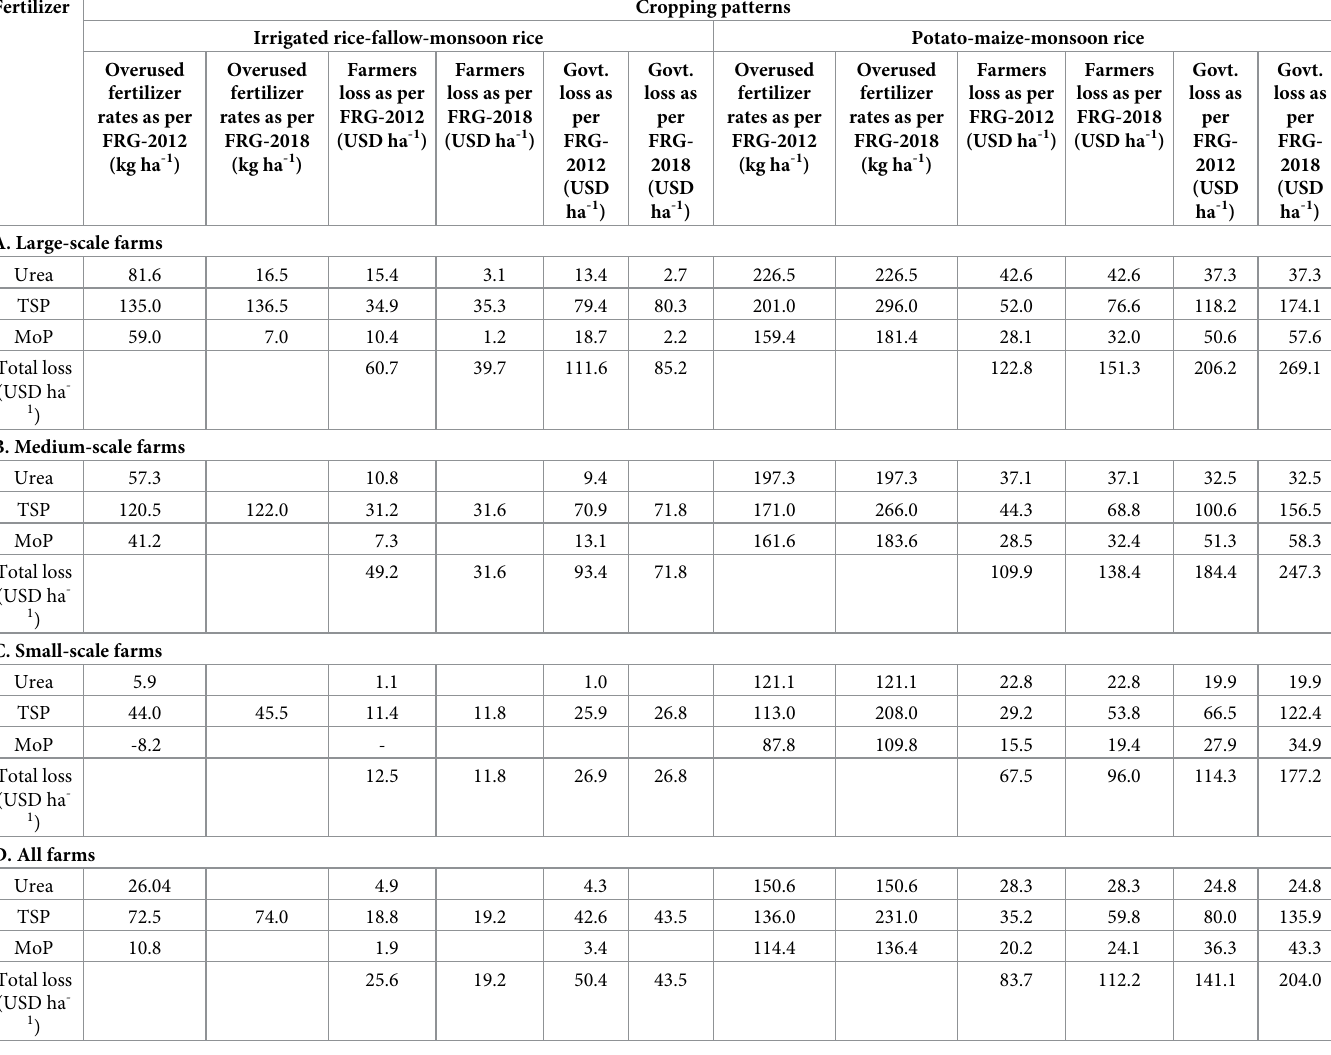
Table 4. Financial loss (USD ha -1 ) of the farms and Government from overuse of NPK nutrients under rice-based cropping patterns in the study areas of the Eastern Gangetic Plain. Fertilizer Cropping patterns Irrigated rice-fallow-monsoon rice Potato-maize-monsoon